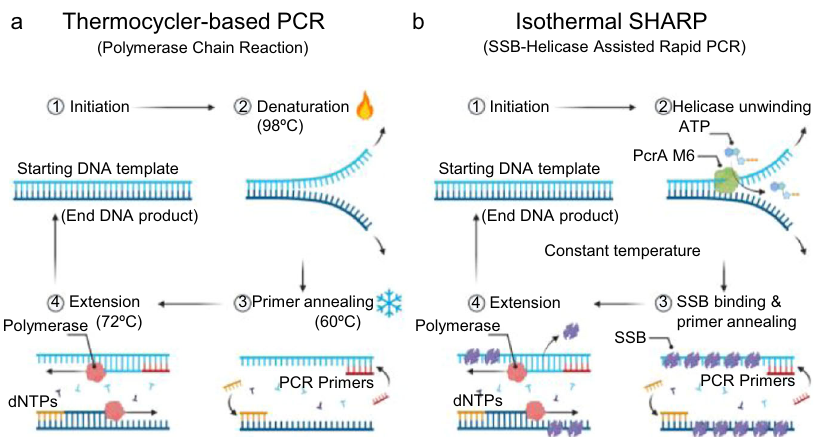
Fig.1|ComparisonofPCRandSHARP.a PCRalternatesthetemperaturebetween high ( ≈ 98°C) to melt the DNA duplex and low (45 – 65°C) to replicate the com- plementary strand by a DNA polymerase. b SHARP uses PcrA M6 helicase and SSB